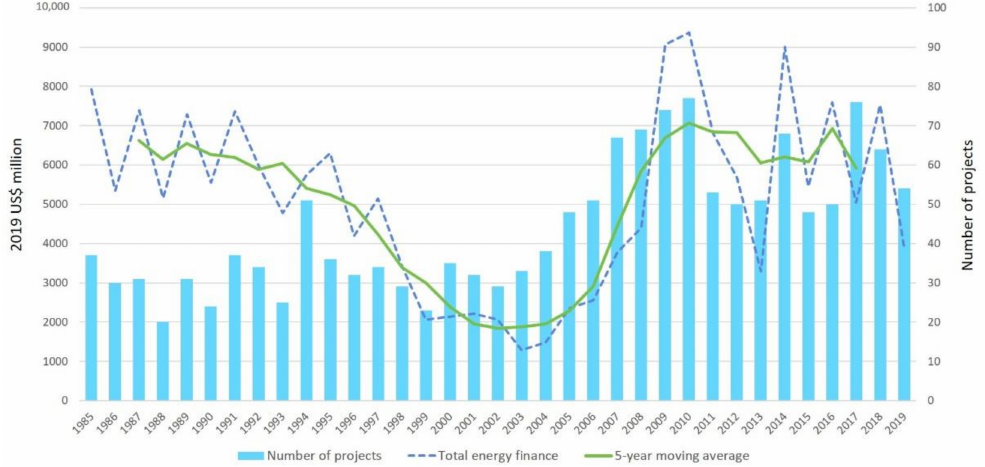
Figure 4. Total energy finance and number of energy-related projects (1985–2019). Source: authors’ illustration based on